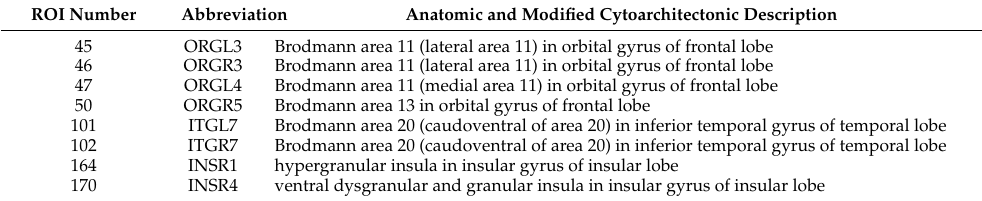
Table 3. (ROIs) * information for sFC strength